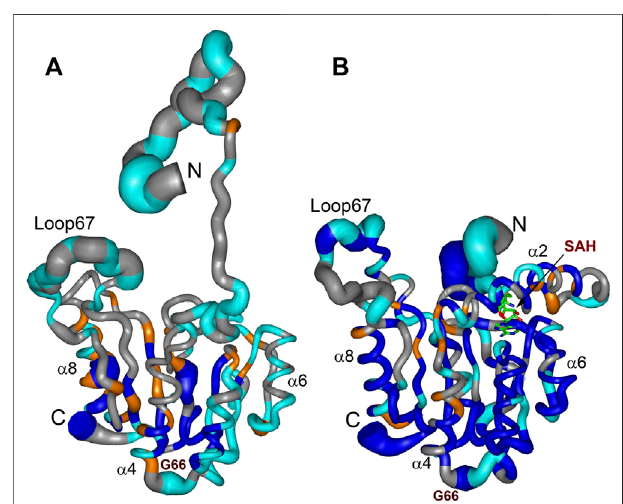
FIGURE 8 | Summary of dynamic and conformational behaviour of the WBSCR27inapo-form (A) andincomplexwithSAH (B) .RepresentativeNMR models of apo-WBSCR27 and complex SAH-WBSCR27 are shown according to protein mobility in a broad time scale. The thickness of the chain is proportional to the value (1 − S 2 ) representing the extent of the local amplitude of protein backbone motion in ps-ns time scale. Fragments of the protein backbone containing amino acids undergoing conformational exchange in ms time scale (with values R ex exceeding 2 s − 1 ) are colored orange. Protein backbone fragments with residues having high values of protectionfactors determined fromtheanalysisofhydrogen-to-deuteriumHN exchangeratesarecoloredblue.Residuesforwhich 15 Nrelaxationdatacould not be obtained (proline residues and those with overlapped HN signals) are shown in gray. Representative secondary structure elements and SAH molecule are